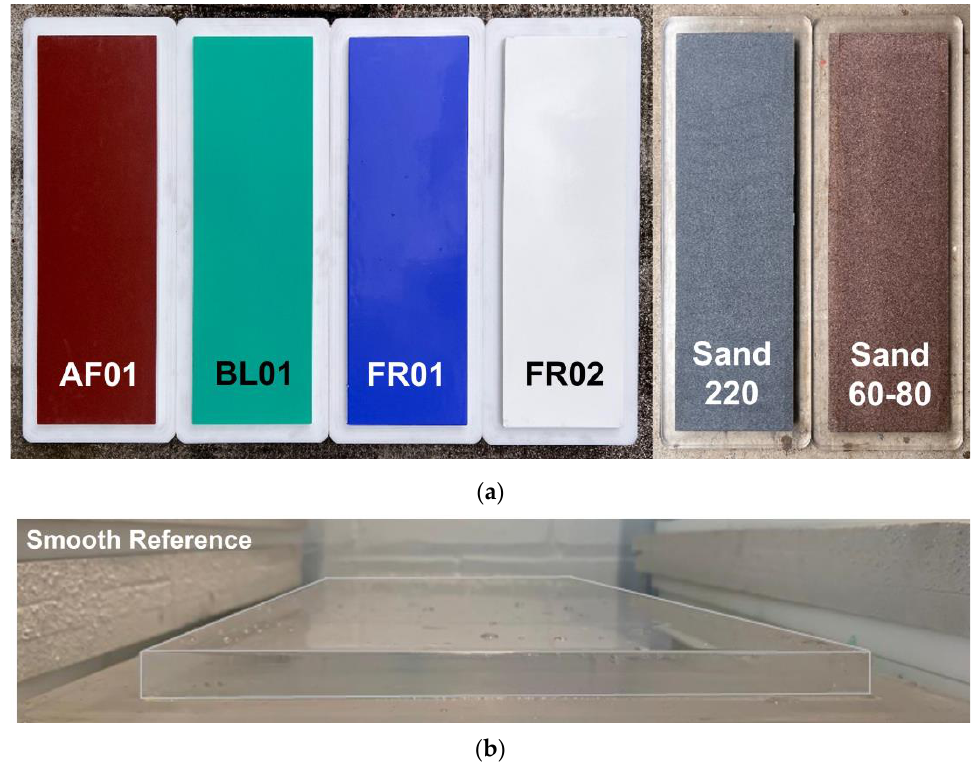
Figure 3. Surfaces tested in the FTFC. ( a ) Test panels coated with different fouling control coatings and sand grit. ( b ) Uncoated smooth reference panel.